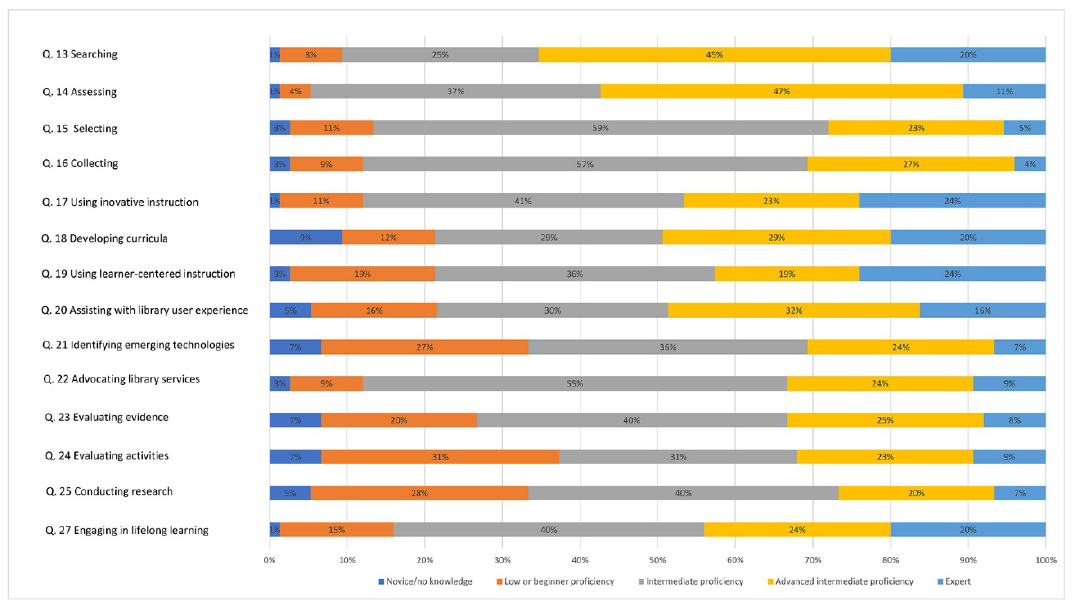
Figure 1 Self-reported MLA competencies and sub-competencies